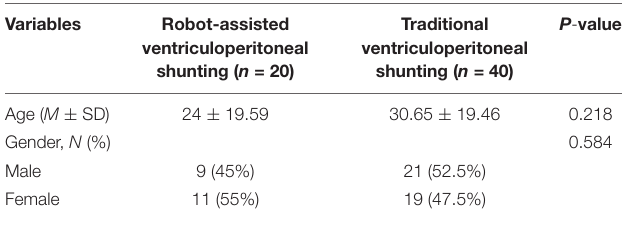
TABLE 1 | Comparison of the characteristics of patients in the robot-assisted and traditional surgery